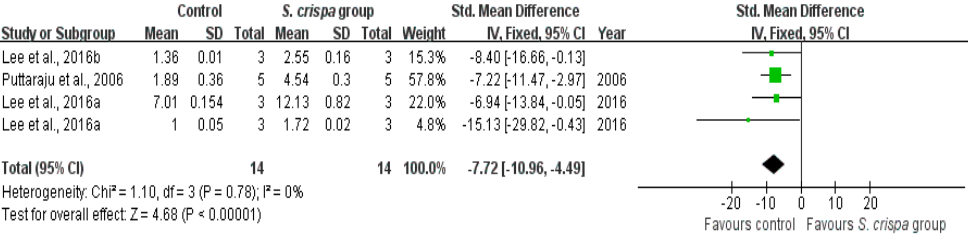
Figure 5. Comparison of levels of tumor activity between control and S. crispa groups. ( ): SMD of Figure 10. Comparison of oxidative inhibitory capacity between control and S. crispa groups. ( individual studies; (  ): summary SMDs of the comparison. Figure 10. Comparison of oxidative inhibitory capacity between control and S. crispa groups. ( Figure 9. Comparison of the anti-fungal activity between control and S. crispa groups. ( Figure 10. Comparison of oxidative inhibitory capacity between control and S. crispa groups. ( SMD of individual studies; (  ): summary SMDs of the comparison.